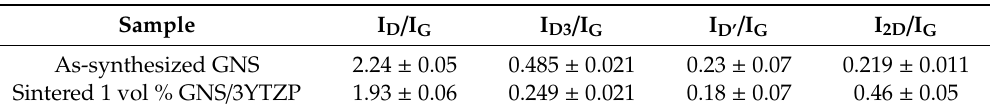
Table 1. Intensity ratios of the D, D 3 , D’ and 2D bands with respect to the G peak, obtained for the as-synthesized graphene-like nanosheets (GNS) and the GNS in the sintered composite after fitting the first- and second-order Raman